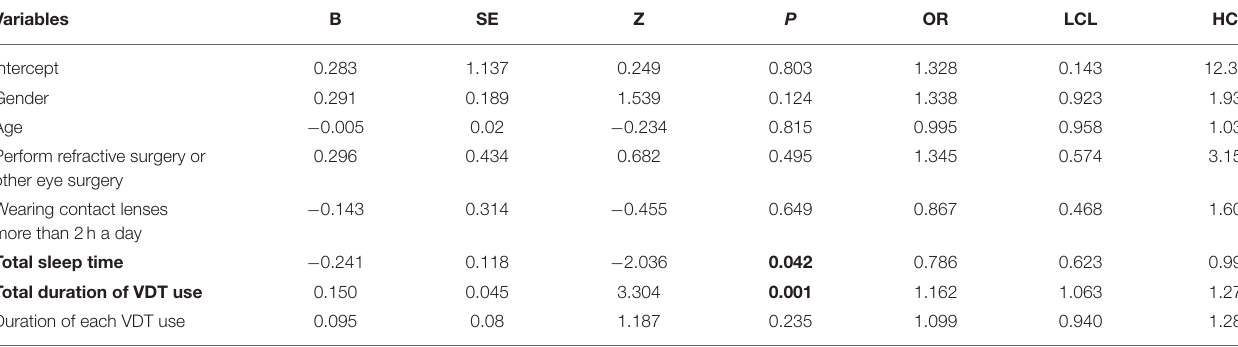
TABLE 3 | Logistic regression model of factors associated with eye discomfort symptom